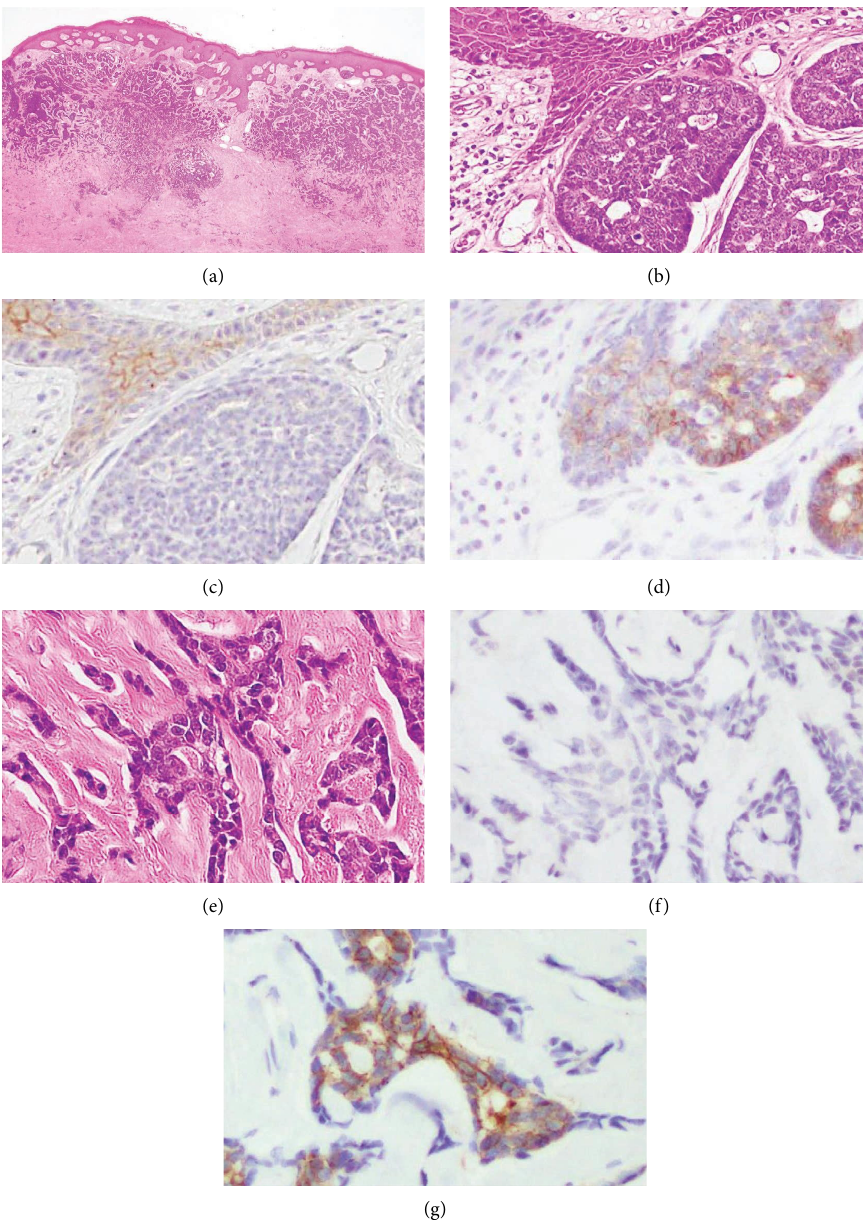
Figure 4: Immunohistochemical results for claudin 1 (c and f) and claudin 4 (d and g) and corresponding HE-stained sections (b and e) of micronodular BCC (case 1). (a) Micronodular pattern is observed in at low magnifcation in HE-stained section. (b) BCC cells display adenoid cystic architecture in some areas. In these areas, neoplastic cells are negative for claudin 1 (c) and positive for claudin 4 (d). (e) BCC cells show infltrative growth arranged in a trabecular pattern in deep areas. In these areas, neoplastic cells are also negative for claudin 1 (f) and positive for claudin 4 (g). (h) Reactivity for claudin 4 is observed in the membrane and